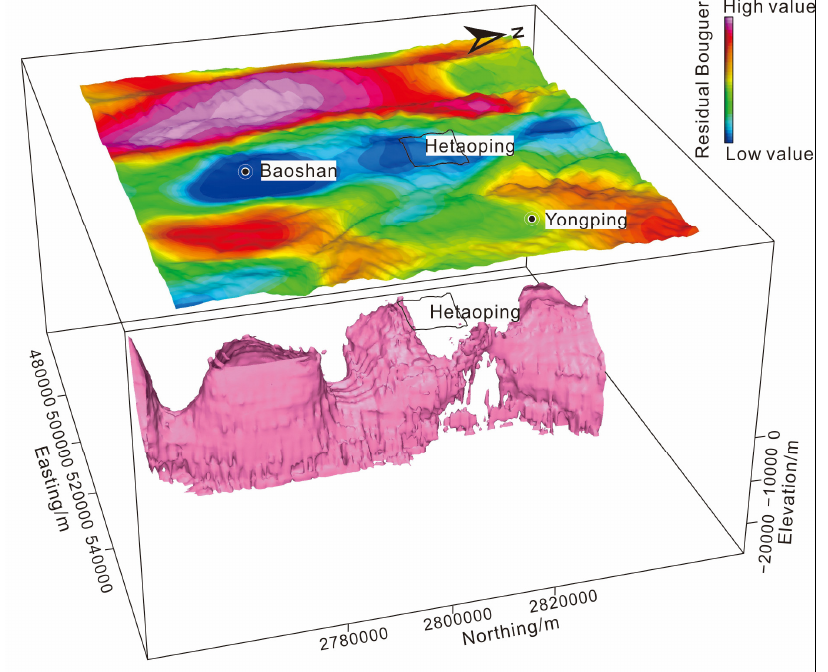
Figure 7. Spatial morphology of the deep magma chamber from the 3D inversion of gravity data. Residual Bouguer gravity anomalies were extracted using the square window moving average filtering method, and the side length of the sliding window was 30 km. The top colored shadow map shows the regional residual Bouguer gravity anomalies superimposed on the terrain, and the lower pink isosurfaces (density ρ = − 0.032 g/cm 3 [5,39]) are the inferred boundaries of deep concealed intrusions.